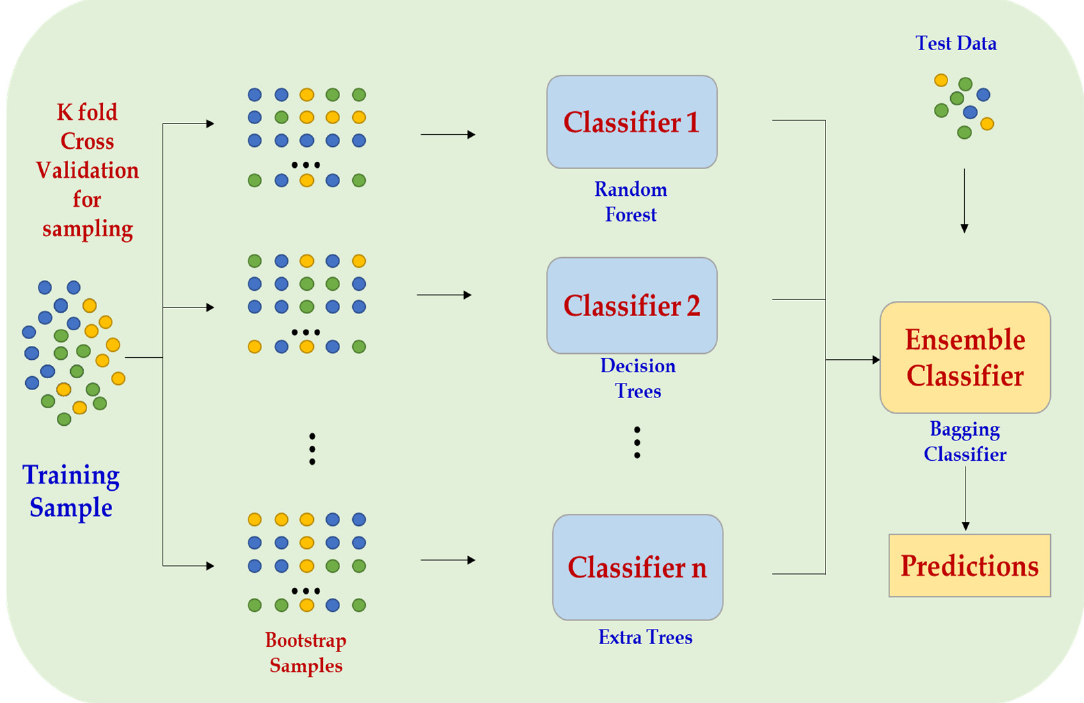
Figure 8. The Process Flow of Bagging decision trees (Bootstrap Aggregation). Courtesy.